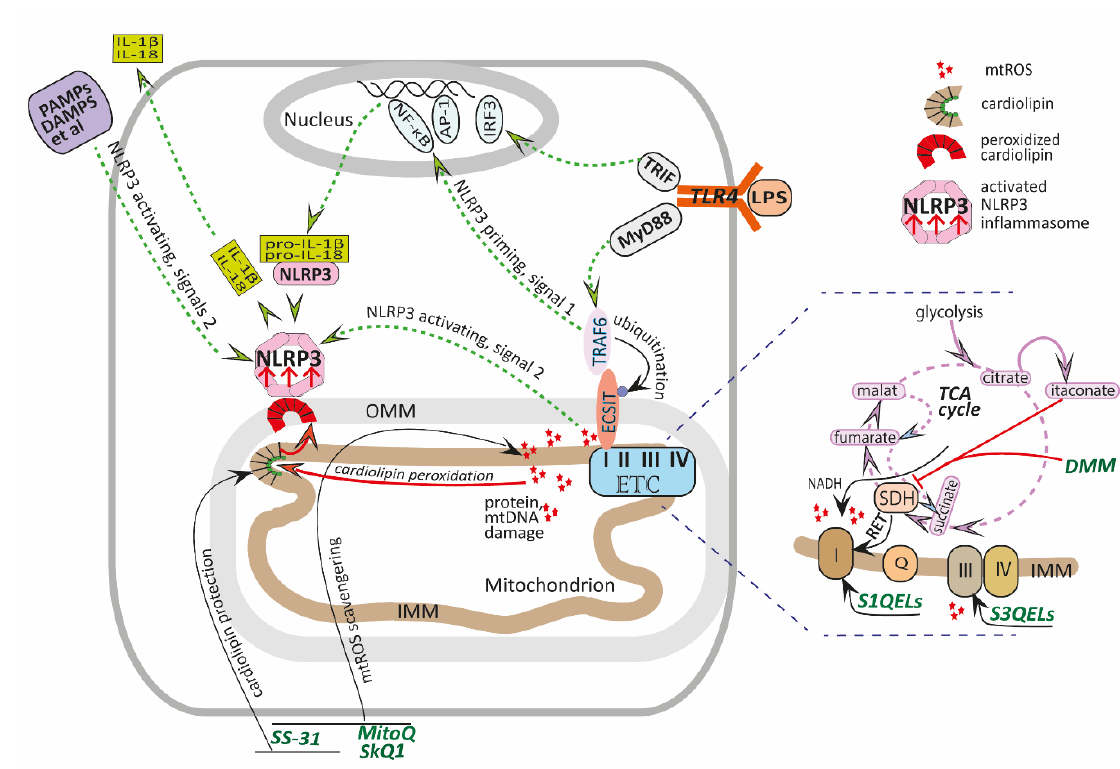
Figure 1. Diagram illustrating the protective mechanisms of mito-AOX against the LPS-induced cell inflammatory response. Activation of TLR4 by LPS triggers MyD88- or TRIF-dependent signaling pathways, resulting in the translocation of nuclear transcription factors NF- κ B, AP-1, and IRF3 into the nucleus. This leads to the initiation of transcription of a wide range of pro- and anti-inflammatory mediators. LPS-induced priming of the NLRP3 inflammasome mediated by the adapter protein TRAF6 and NF- κ B results in transcription of NLRP3 and inactive pro-IL-1 β and pro-IL-18 proteins. In addition, TRAF6 is translocated to the mitochondria and ubiquitinates ECSIT, a protein implicated in complex I assembly and stability, resulting in its enrichment at the mitochondrial periphery and facilitation of mtROS production. Complexes I and III of the ETC are the main sites of mtROS production. In conditions of low forward electron transport, complex I can generate mtROS via NADH oxidation as well as via reverse electron transport (RET) from SDH to complex I (see the text). Inhibition of SDH by the TCA cycle derivative itaconate, as well as malonate or cell-permeable dimethyl